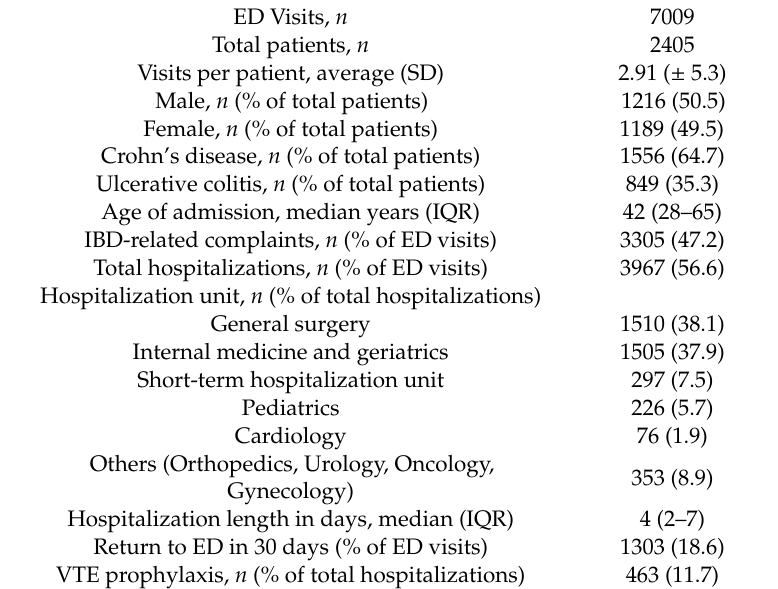
Table 1. Summary of ED visits and hospitalization-related factors in patients with